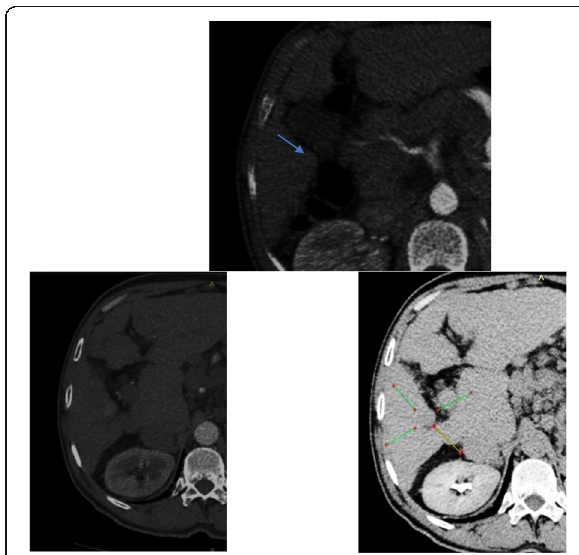
Fig. 7 Case 4: a 63-year-old male patient with cirrhosis. a MDCT in the arterial phase dated November 2016 reveals a small segment V right lobe hyper-enhancing nodule measuring 12 mm showing no washout in the venous nor the delayed phases (not shown); this lesion is categorized as LIRADS 3. b , c MDCT in the arterial and delayed phases for the same patient 6months later showing size progression of the lesion measuring 21mm with development of mild washout; in the second study, the lesion is classified as LI-RADS